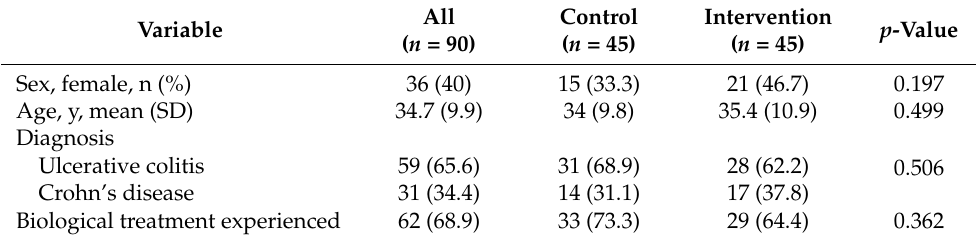
Table 1. Characteristics of the participants in the intervention and control group. Variable